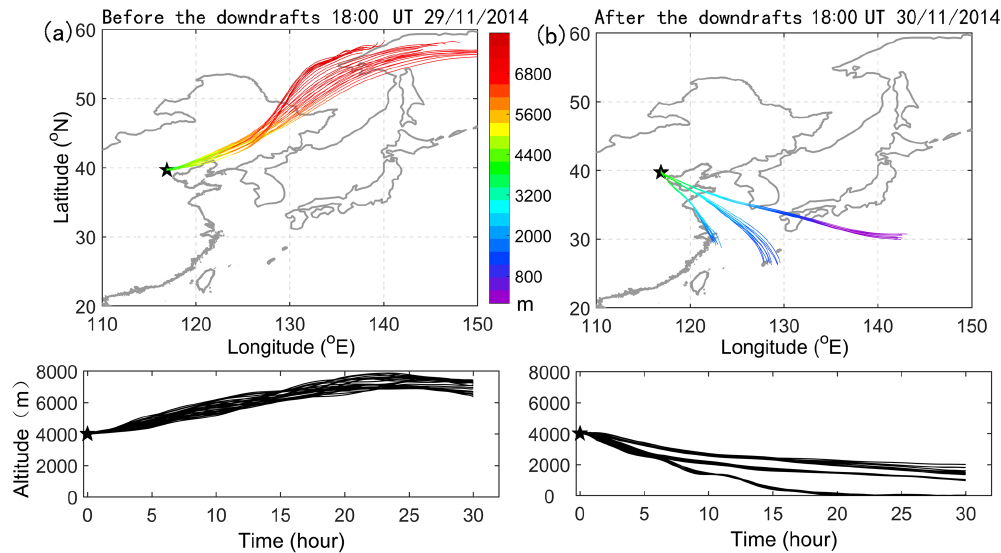
Figure 10. Same as Fig. 10 but for three-dimensional forward trajectories starting at Xianghe at 4000m: (a) before the main downdrafts at 00:00UTC on 30 November 2014, and (b) after the main downdrafts at 00:00UTC on 1 December